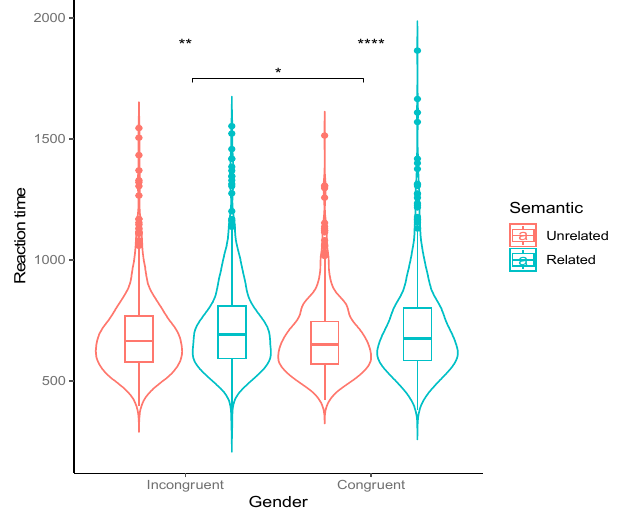
Figure 2. Picture naming latencies by condition. Both gender congruency and semantic relatedness showed a significant effect on naming latencies (i.e., p < 0.0001, indicated as “****”; p < 0.01, indicated as “**” and p < 0.05, indicated as “*” respectively in the